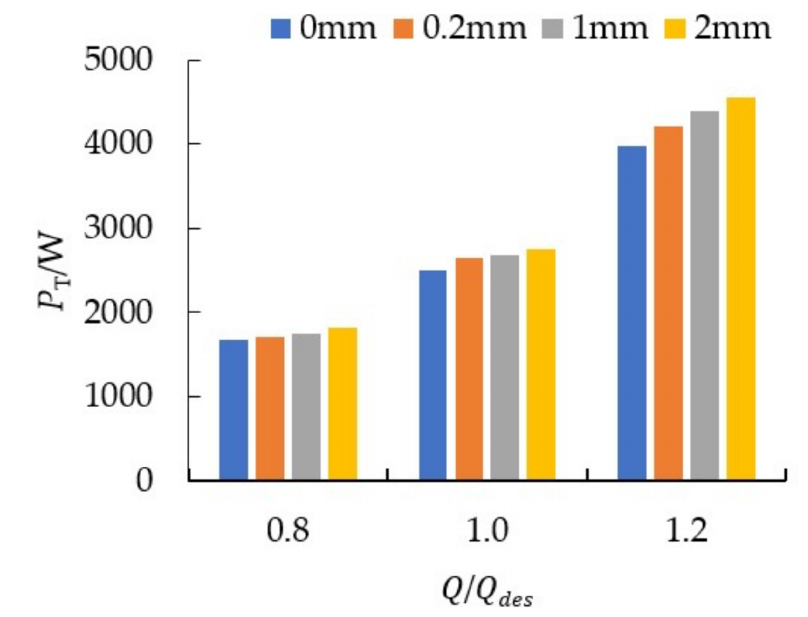
Figure 8. Influence of tip clearance on total dissipation under turbine